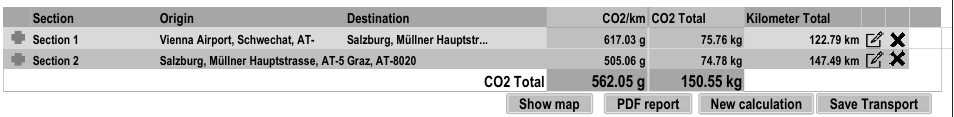
Fig. 4. CO 2 -emissions per km and in